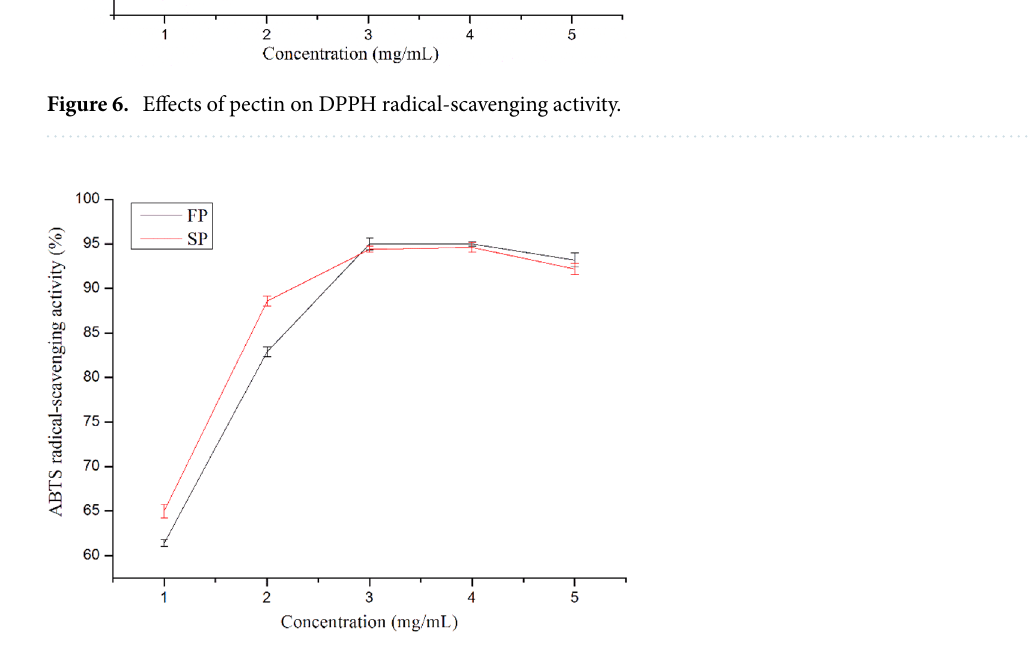
Figure 7. Effects of pectin on ABTS radical-scavenging